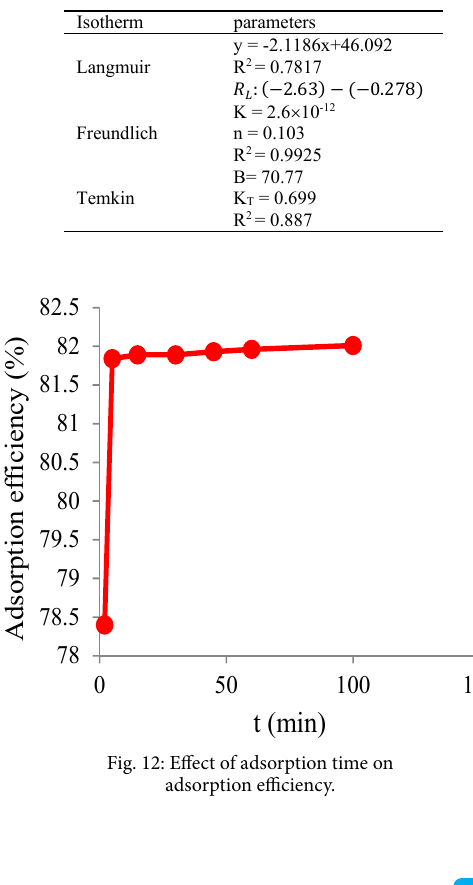
3: Isotherm parameters for cadmium